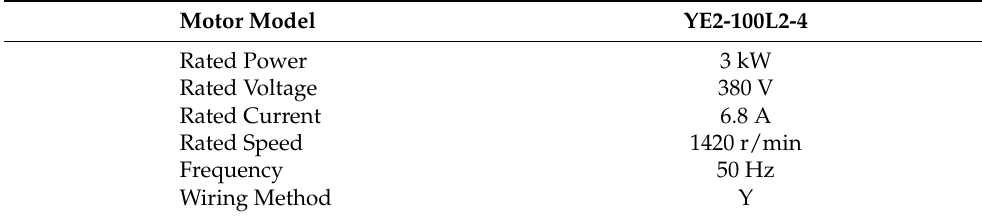
Table 2. Parameters of 3 kW